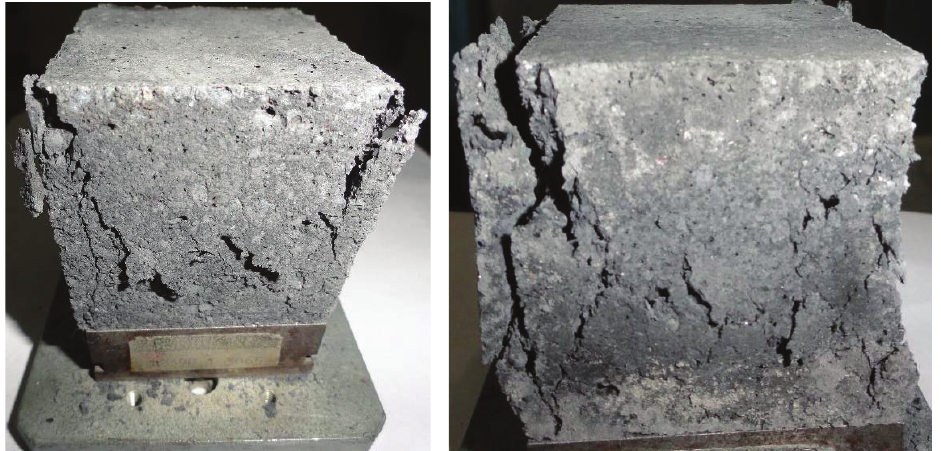
Figure 10: Failure mode.